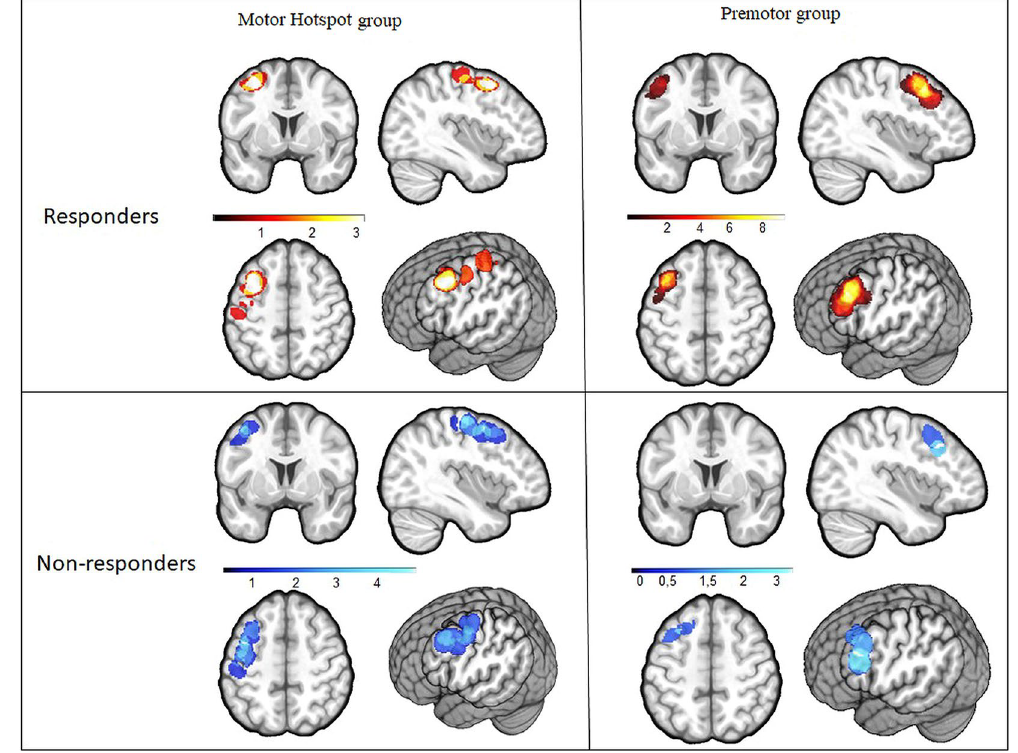
Figure 5. Heat map of the stimulation site between responders and non-responders in the Motor Hotspot and Premotor groups. This figure displays the location of the anatomical stimulation sites in the participants allocated to the Motor Hotspot group (n = 14) for the 7 responders (hot heat map) and the 7 non-responders (cool heat map), and to the Premotor group (n = 15) for the 11 responders and the 4 non-responders. The majority of the responders in both Motor Hotspot and Premotor groups received stimulation over the same spot within the PMd anatomical boundaries (see also Supplementary Fig.